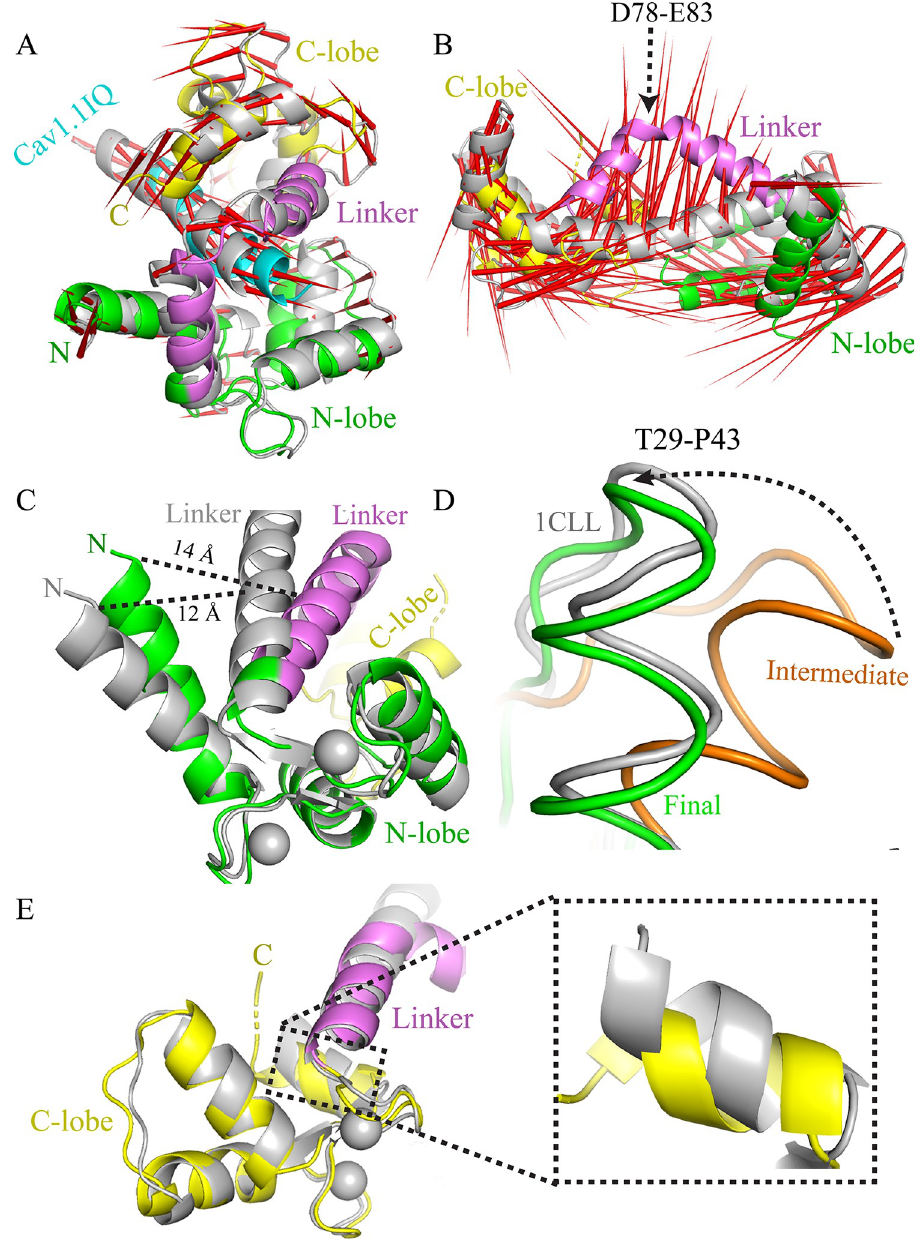
Fig 5. Principal component study of CaM. (A) Among various Ca 2+ /CaM-IQ motif complexes, only the Ca 2 + /CaM-Cav1.1IQ structure (2VAY) reveals slight movements in the C-lobe and the IQ peptide. Modevector (red arrow) represent the flexible region. (B) Extended Ca 2+ /CaM shows significant conformational change in the central helix region. The central helix bends by ~84˚ and adopts a compact form. (C) Intermediate states of the N-lobes during structural transition of the linker region. The helix α 1 (EF1) is seen 2 Å away from its initial position. (D) Similarly, region T29-P43 is observed in an intermediate position (orange) during the course of simulation. This fragment attains final stable position at the end of simulation (green). (E) C-lobe is similar to the original structure except for the α 2 helix region of EF4 (inset).